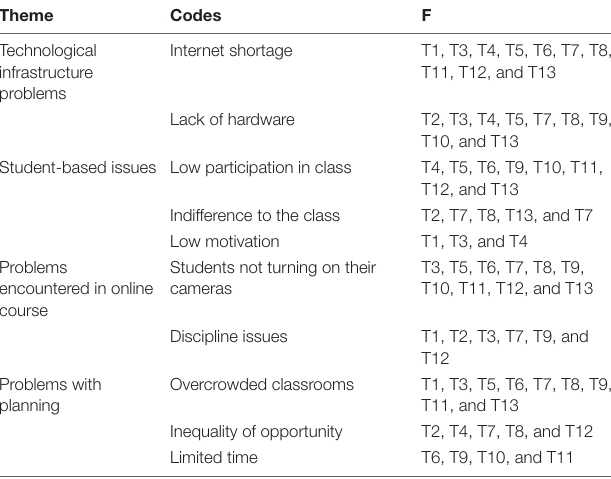
TABLE 3 | Difficulties faced by teachers in distance education